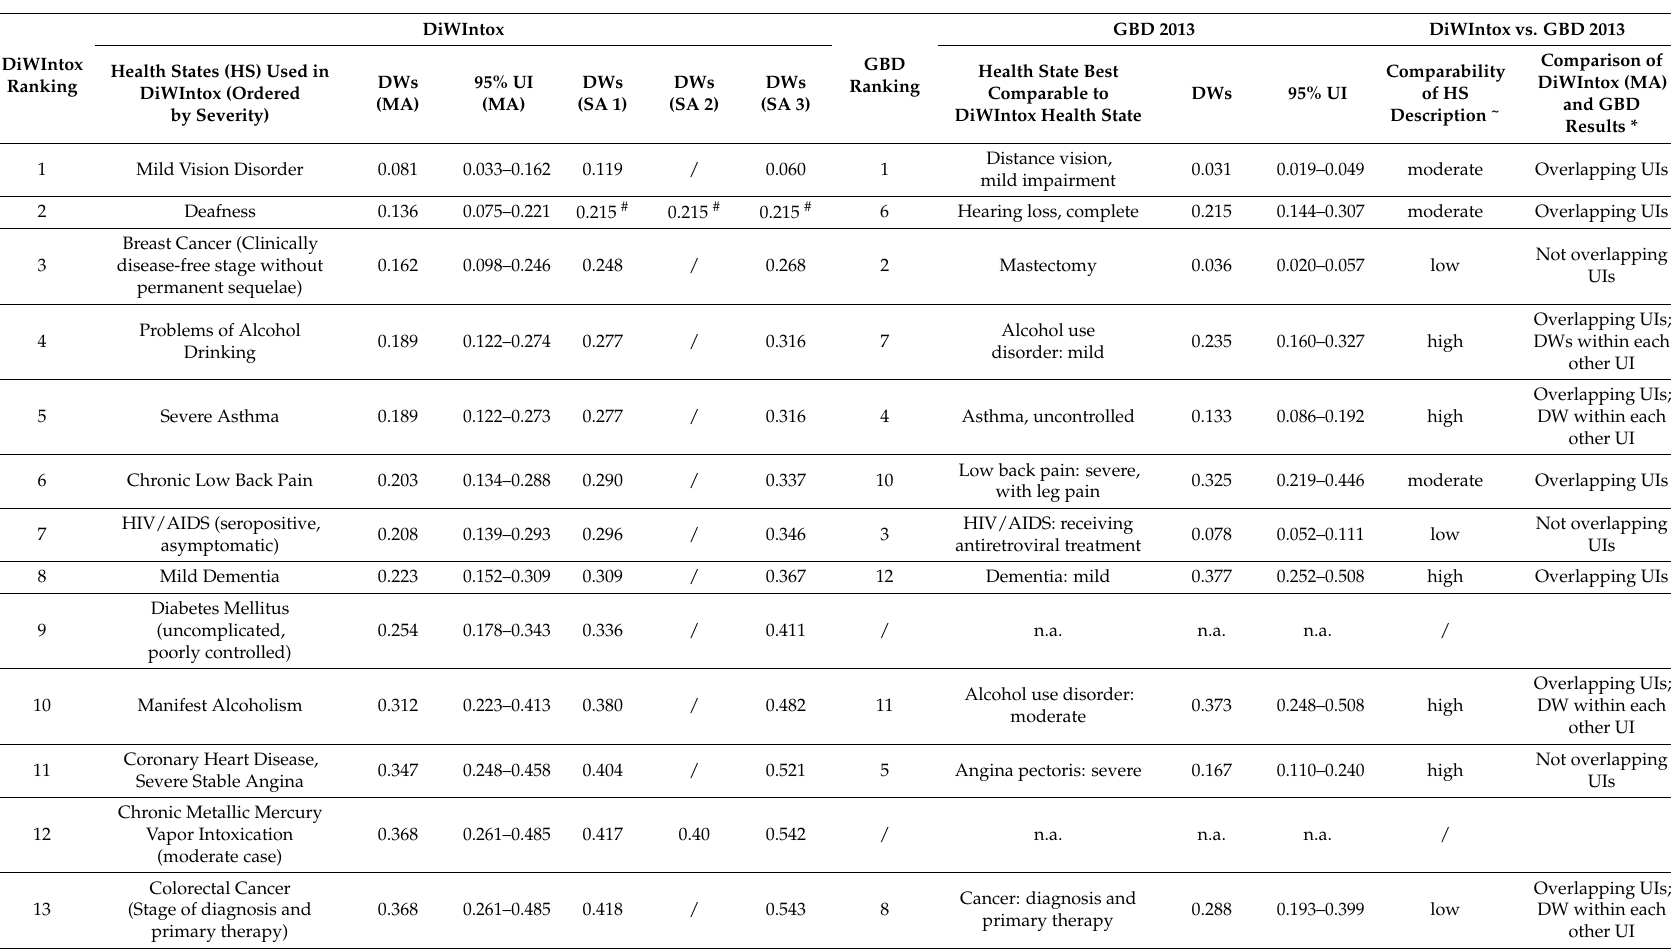
Table 4. Disability Weights (DWs) of main and scenario analyses in comparison with GBD (Global Burden of Disease) 2013 DWs and comparability of health state